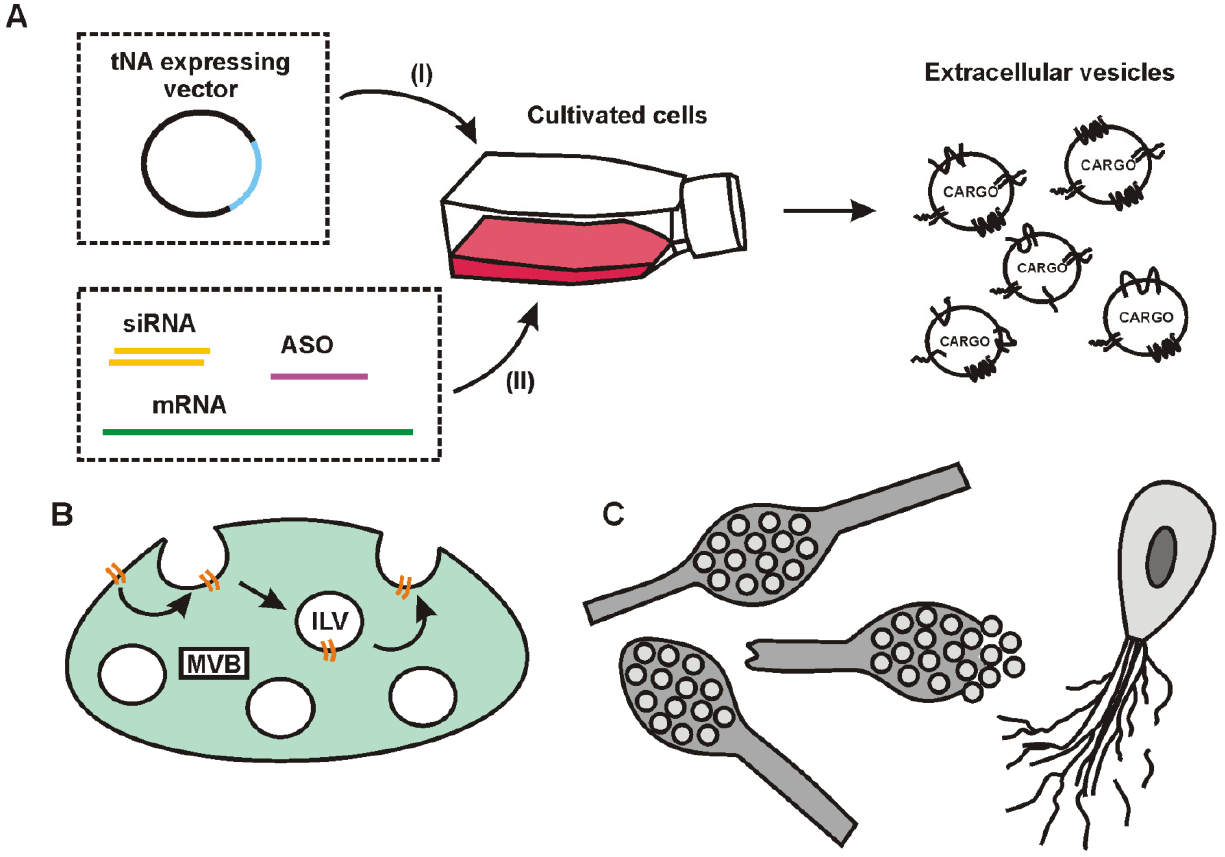
Figure 2. The endogenous strategies of tNA loading into EVs and schematic illustration of exosome and migrasome formation. ( A ) Endogenous strategies for tNA loading. The first (I) strategy is based on cell transduction, transfection, or electroporation by a tNA expressing vector. The second strategy (II) is based on the direct delivery of tNAs into EV-secreting cells. ( B ) Scheme of the ILV back-fusion. ( C ) The long tubular retraction fibers are formed by migrating cells during movement. Migrasomes localize on the tips or at the intersections of retraction fibers and contain numerous smaller (Ø 50–100 nm) vesicles. They are released into the extracellular environment after the fiber breaks. Apparently, in some cases, smaller vesicles inside them can exit into the extracellular space. ILV—intraluminal vesicle; MVB—multivesicular body; ASO—antisense oligonucleotide; siRNA—small interfering RNA.